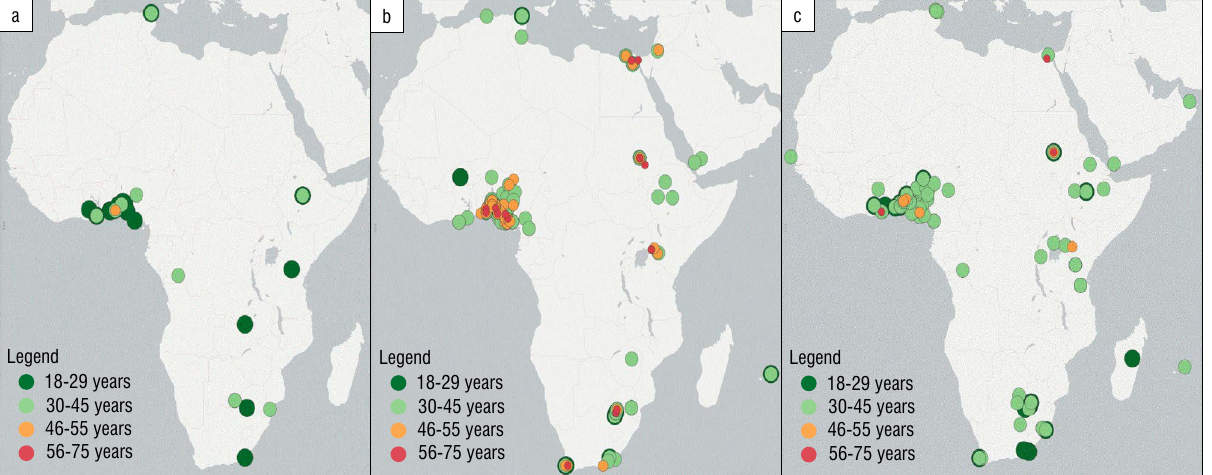
Figure 7: Age distribution by (a) graduate, (b) postgraduate and (c) doctoral